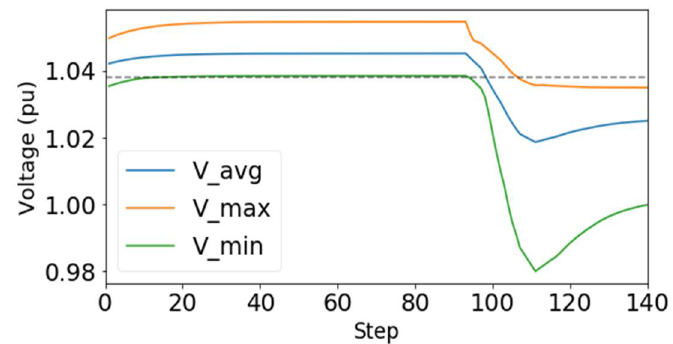
Figure 9. Preliminary functionality test results of voltage regulation.